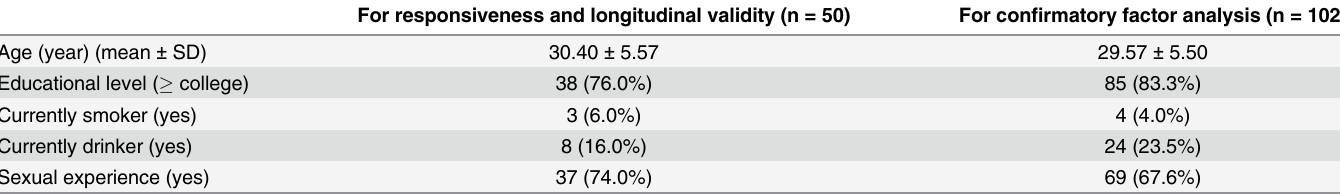
Table 1. Participants characteristics at